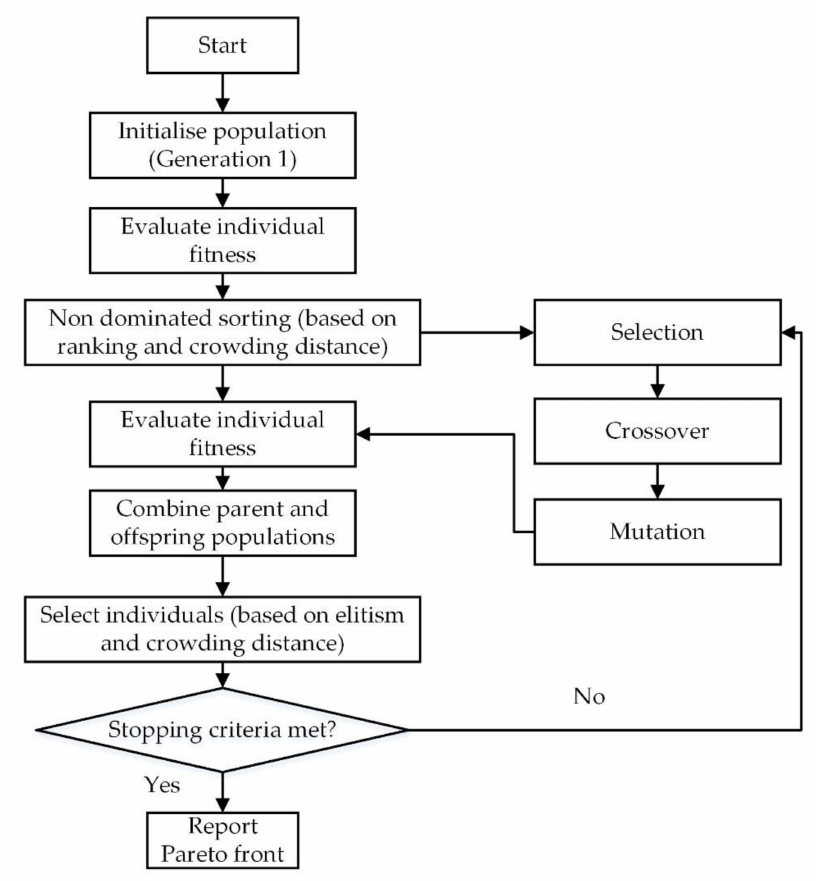
Figure 5. A flowchart of the NSGA-II